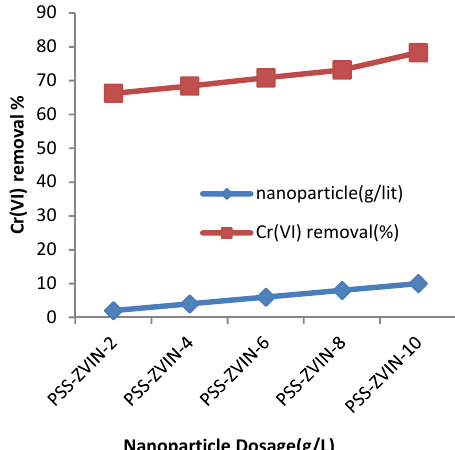
Fig.6.The removal efficiency of Cr(VI) using PSS-ZVINs as afunction of PSS-ZVINs dosage